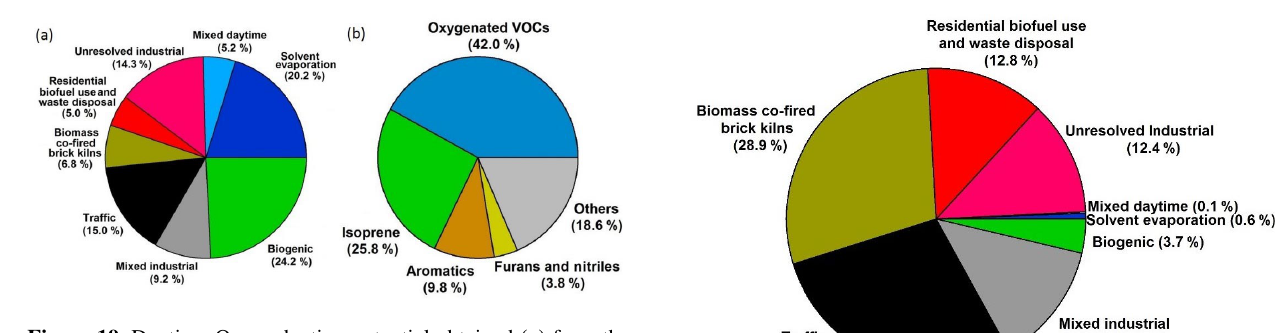
Figure 19. Daytime O 3 production potential obtained (a) from the source contribution using PMF and (b) from the measurements per- formed in the Kathmandu Valley.